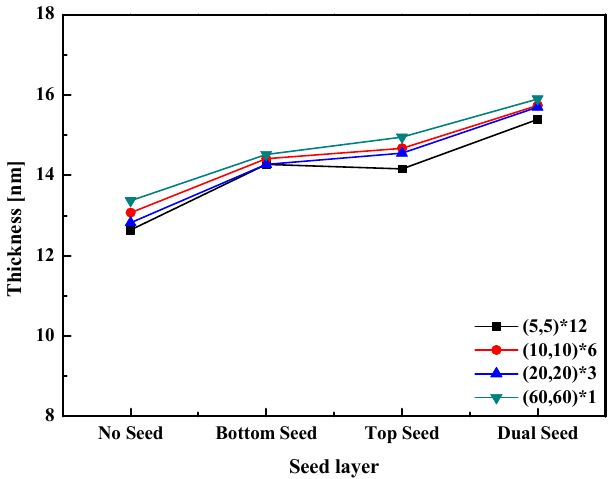
Figure 4. Thickness of the HZO thin films of the HZO nanolaminates.